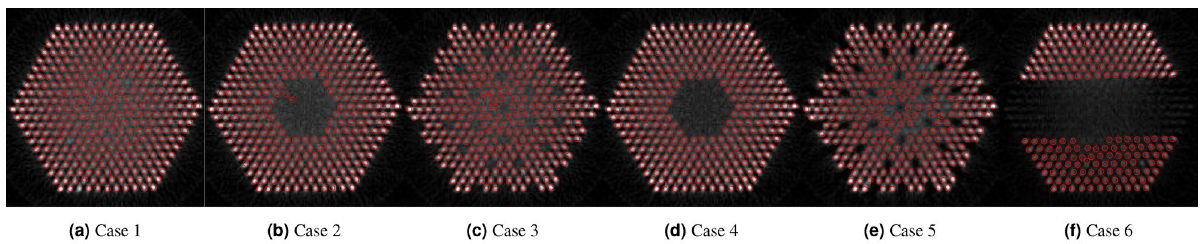
Figure 10. Pin identifications based on FBP. Identified pins are shown as red circles. Mis-classification of fuel pins appeared mostly at the center of Case 1, Case 3, and Case 5, where the hexagonal symmetry of the pin distribution was